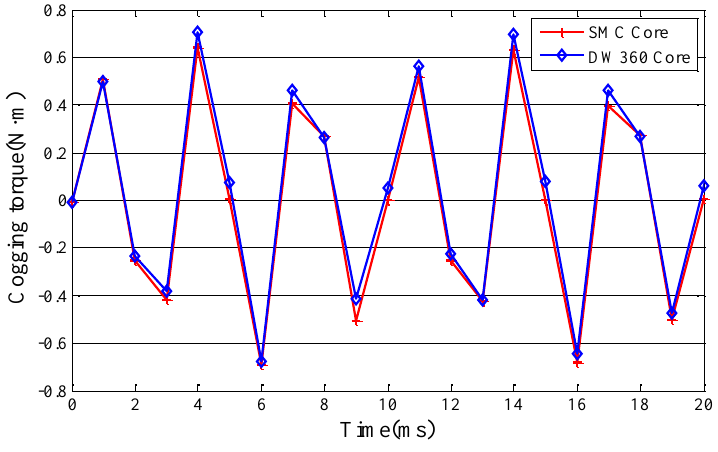
Figure 12. Cogging torque curves with different materials.